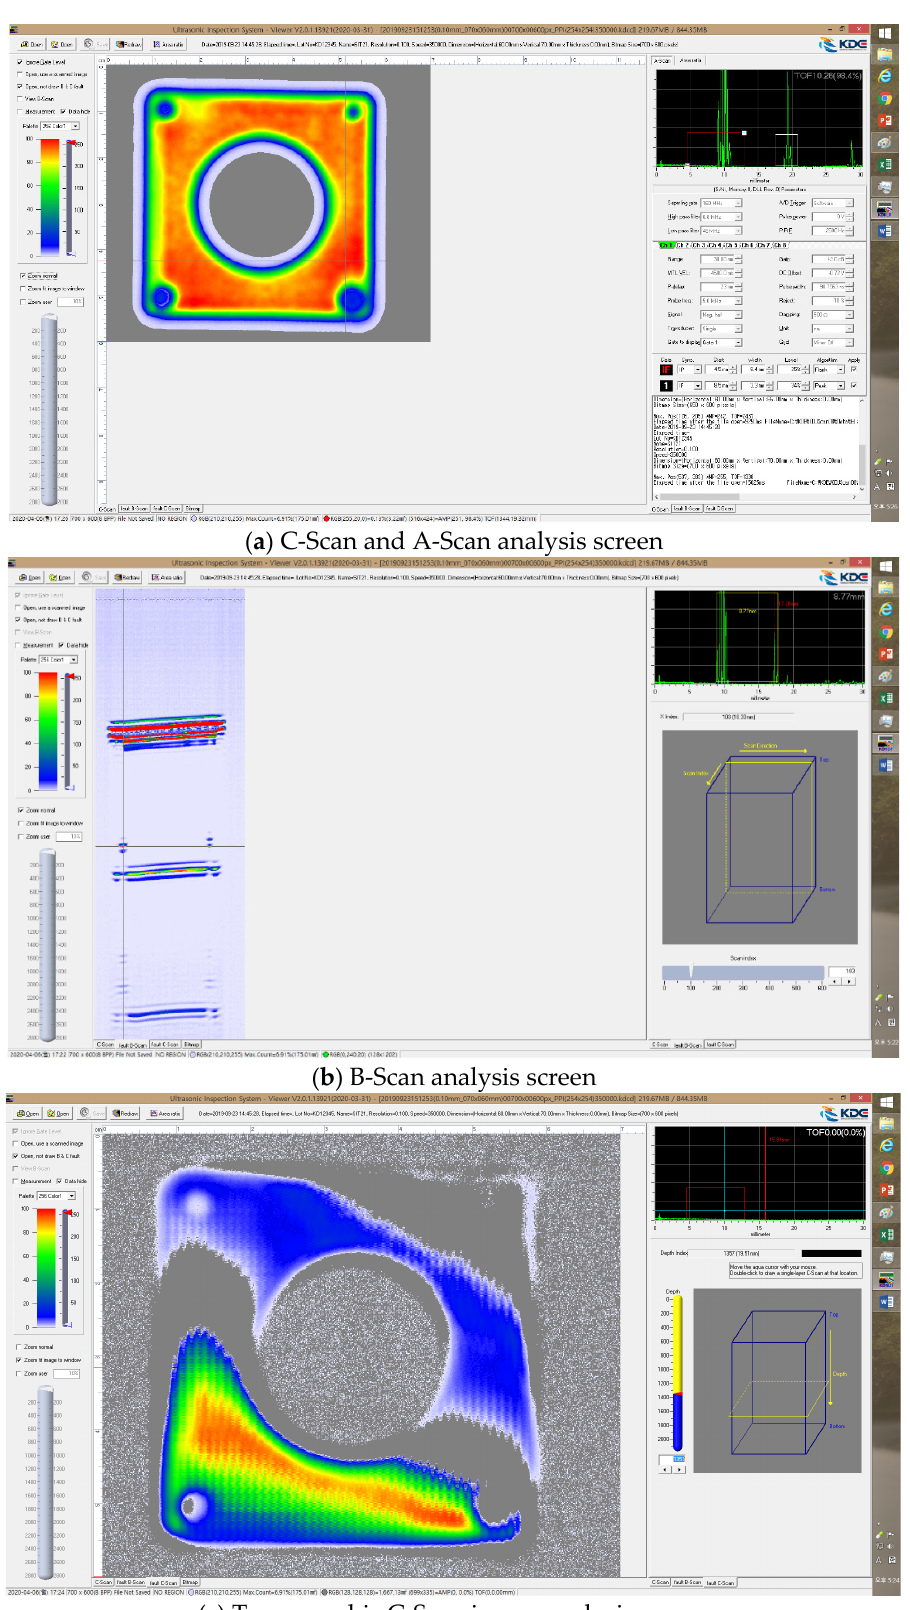
Figure 9. Analysis software. Figure 9. Analysis 4. Analysis of TSV Internal Defects